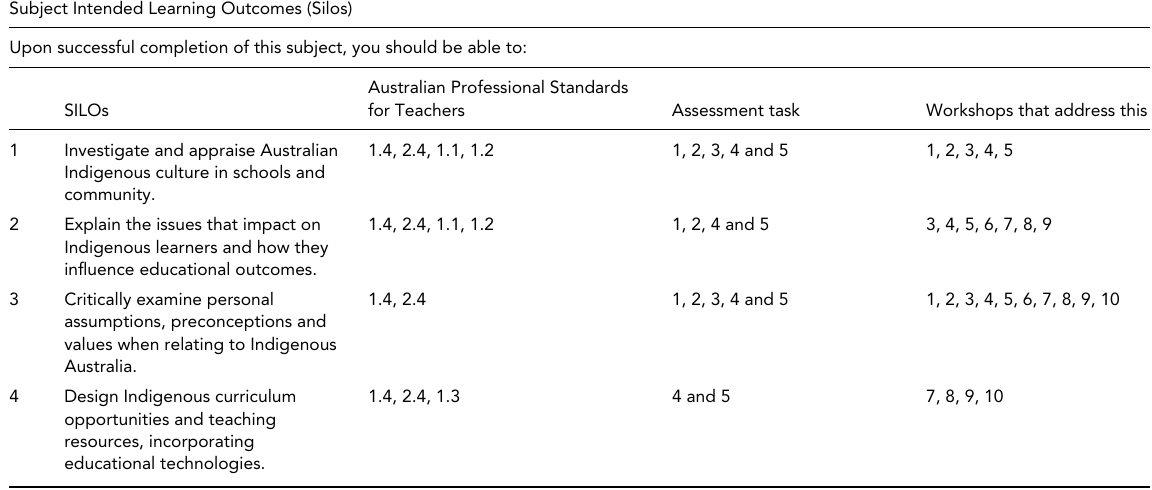
ILO Contribution to Australian Standards, Assessment task, and Activity Subject Intended Learning Outcomes